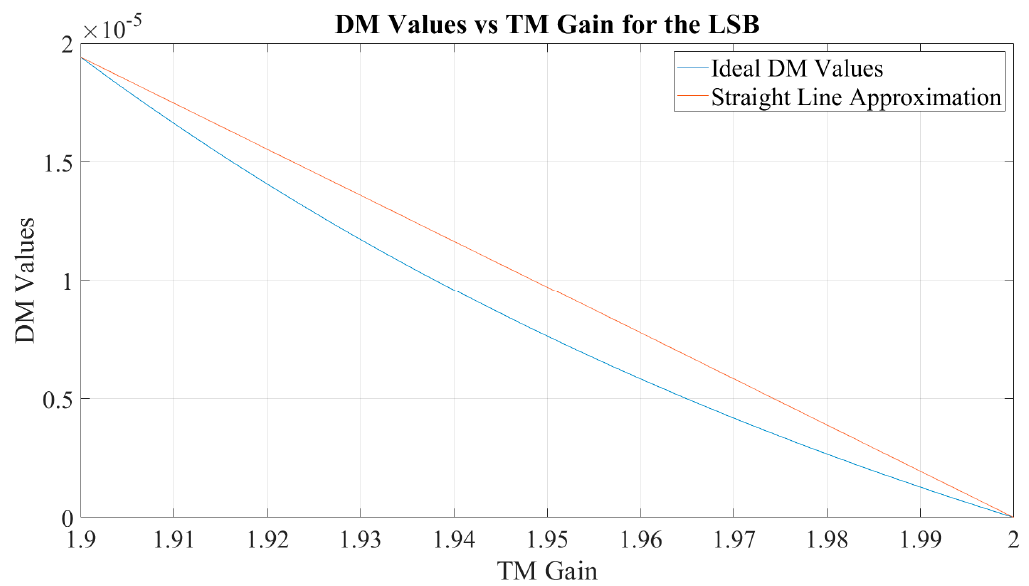
Figure 11. Establishing straight-line approximation of the least significant bit (LSB) difference measure (DM) values.